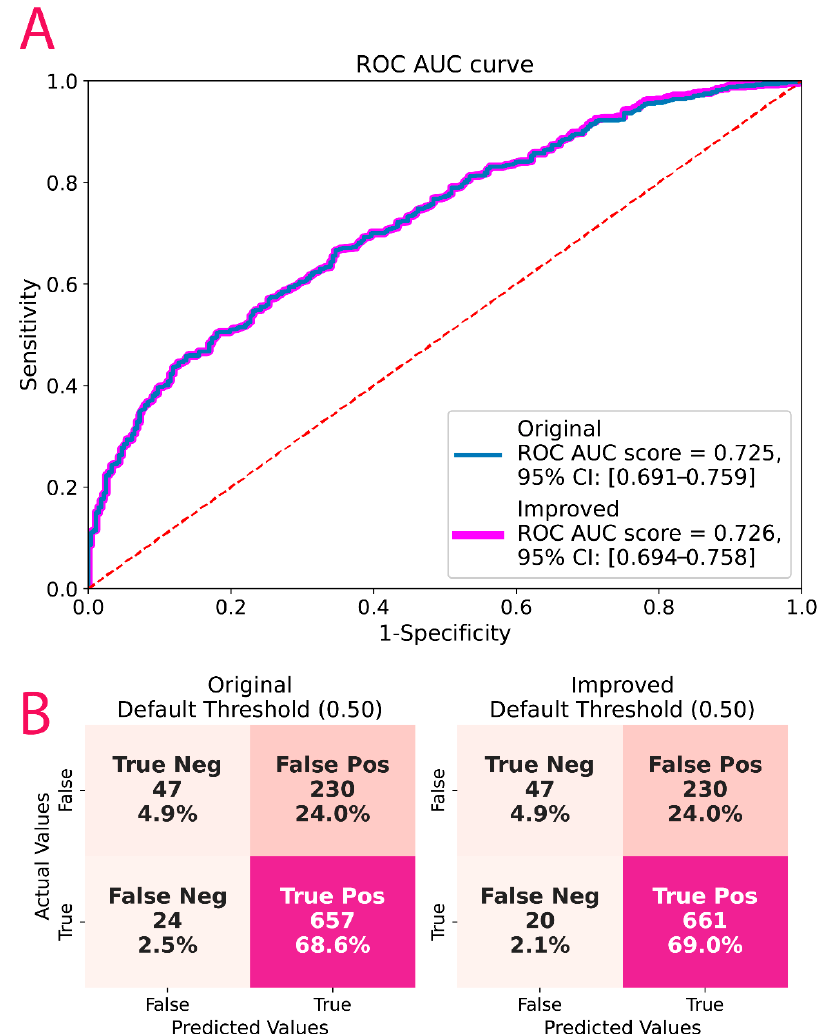
Figure 4. ( A ) Original and corrected ROC AUC of the CorLipid algorithm, ( B ) confusion matrices for true false positive and negative for the original and corrected models.